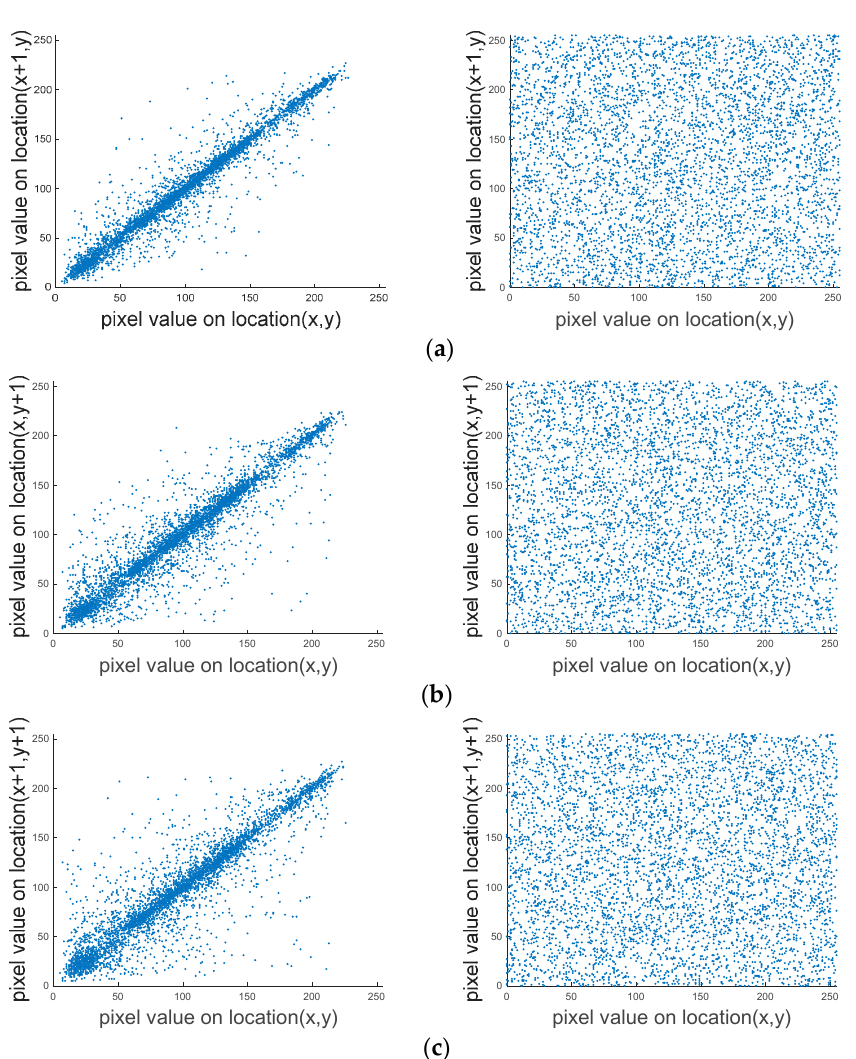
Figure 10. The correlation of Lena in different directions: ( a ) horizontal direction of plain image and cipher image; ( b ) vertical direction of plain image and cipher image; ( c ) diagonal direction of plain image and cipher image.